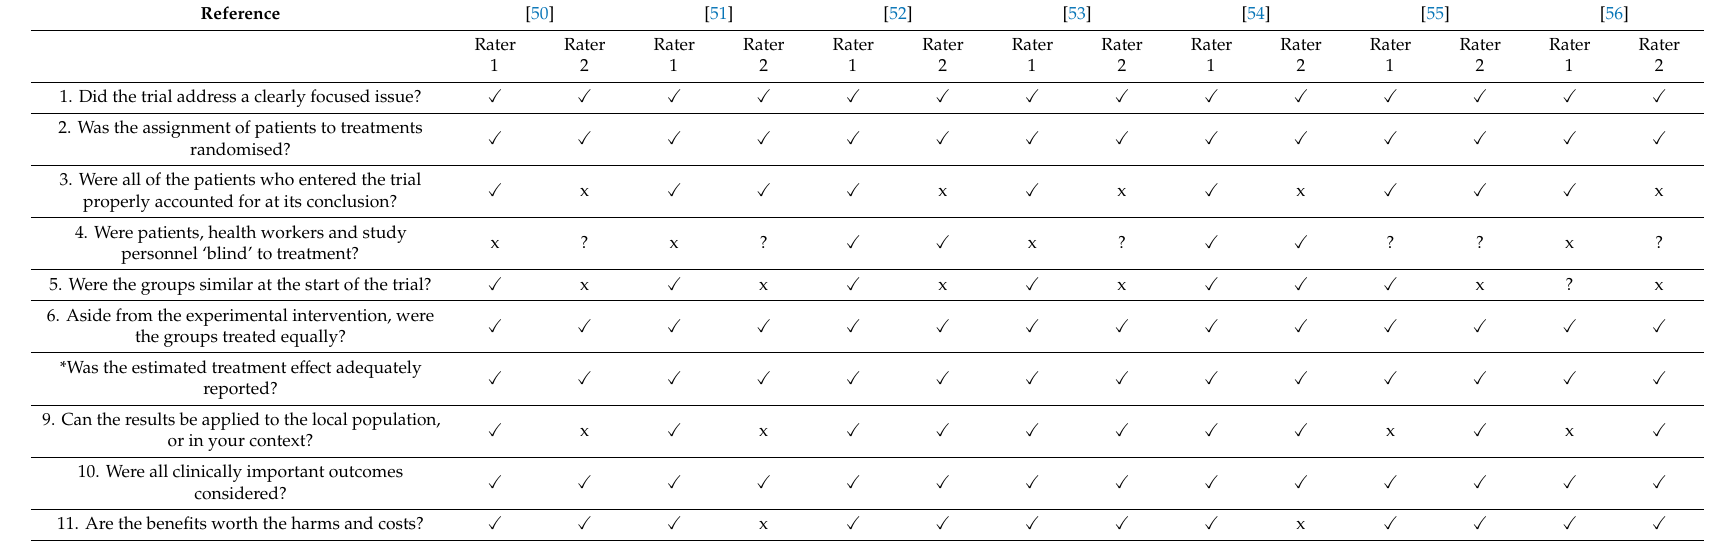
Table A1. Assessment of the quality of the randomized control trials with the CASP (Critical Appraisal Skills Programme)